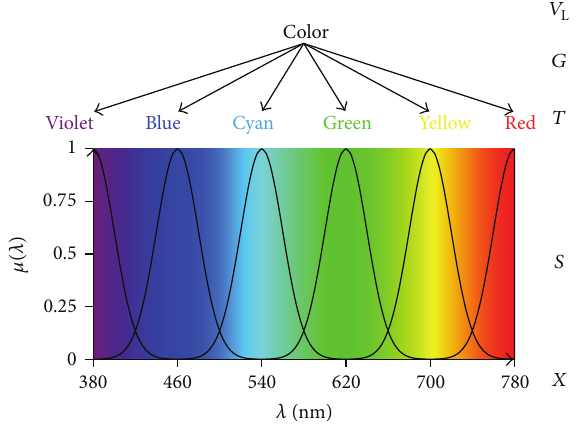
Figure 3: Possible description of the linguistic variable color accord- ing to